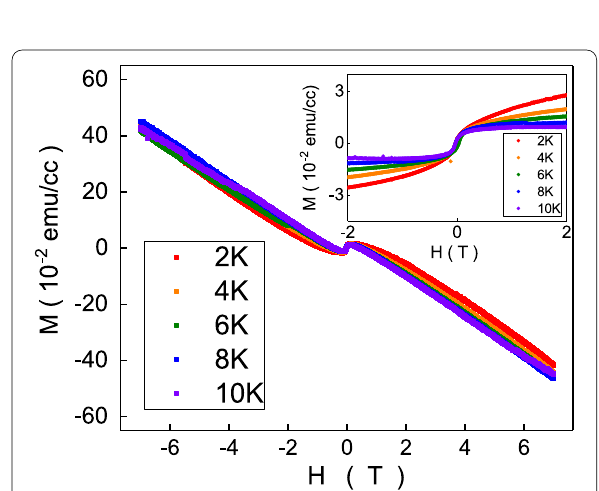
Fig. 3 The magnetization moment as a function of magnetic fields. It is paramagnetic at low magnetic fields and diamagnetic at high magnetic fields. The inset shows the magnetization moment after subtracting the diamagnetism contribution as a function of magnetic fields